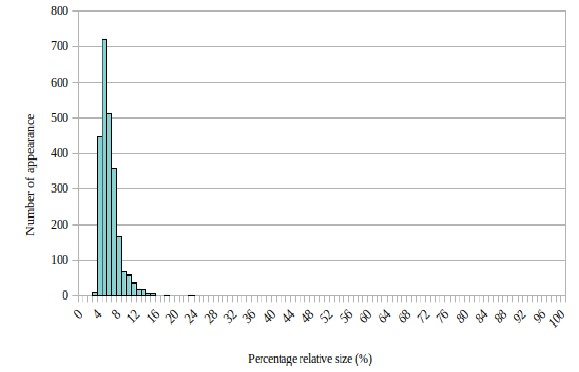
Figure 3. Histogram of relative size distribution (%) of bounding boxes in the TomatOD dataset